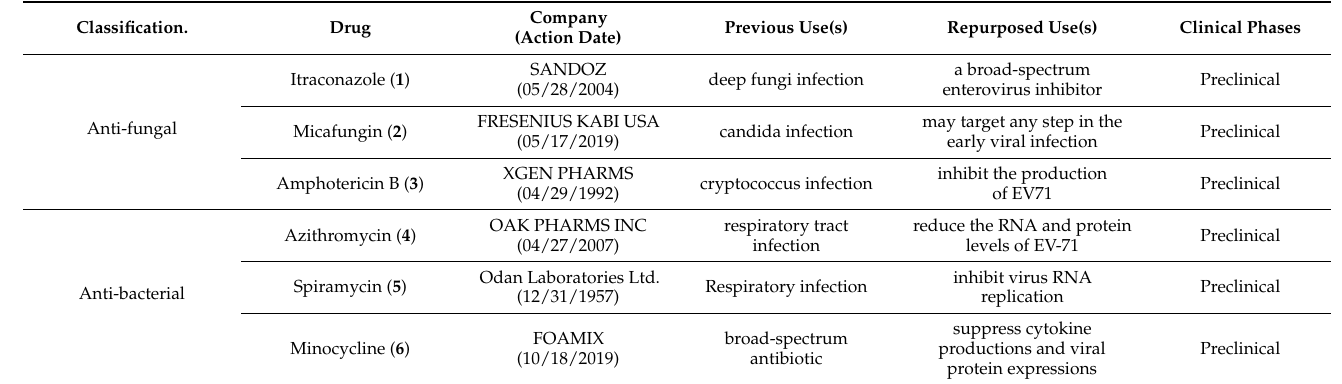
Table 2. Approved drugs repurposed for